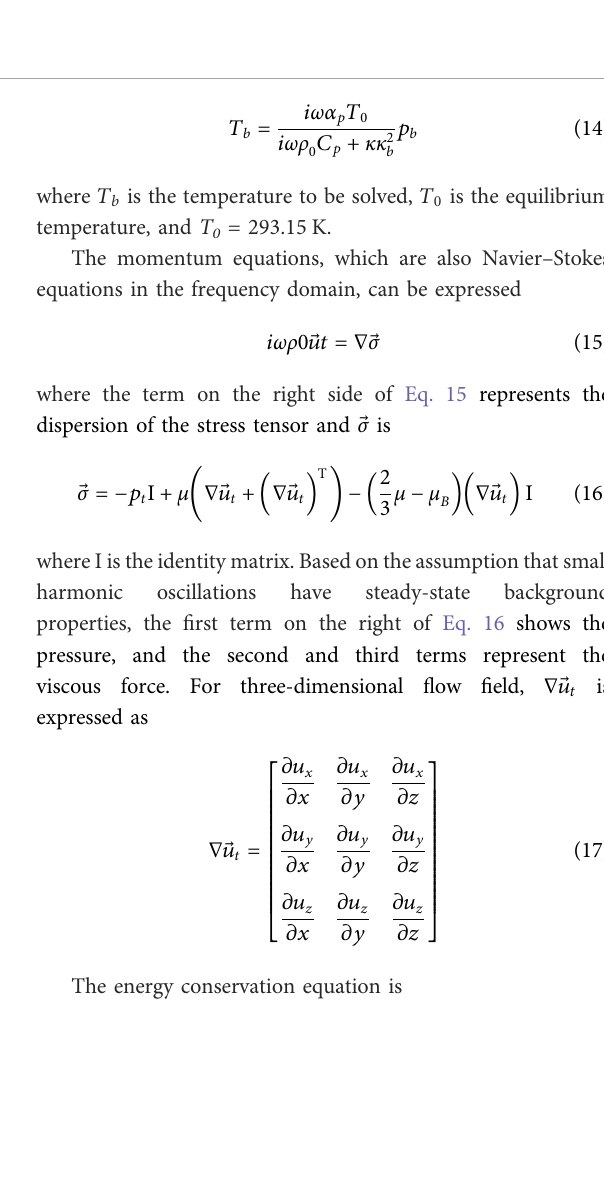
FIGURE 8 The STL of three